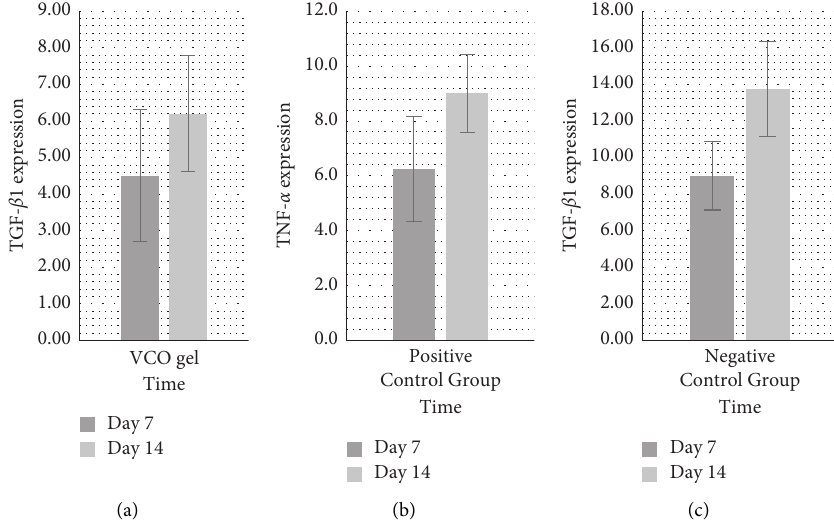
Figure 3: (a) Bar chart showing increased TNF- α on the 7th and 14th day from the three groups. On the 7th day, the group in combination of SRP dan VCO gel had a significant increase. The increase was not as high as in the (b) positive control and (c) negative control group.